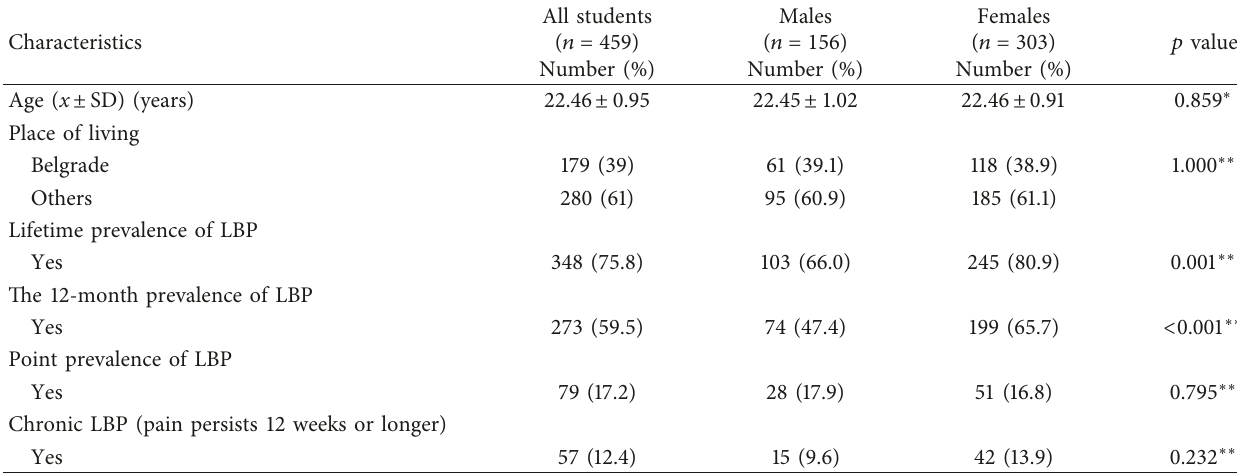
Table 1: Prevalence of low back pain among male and female medical